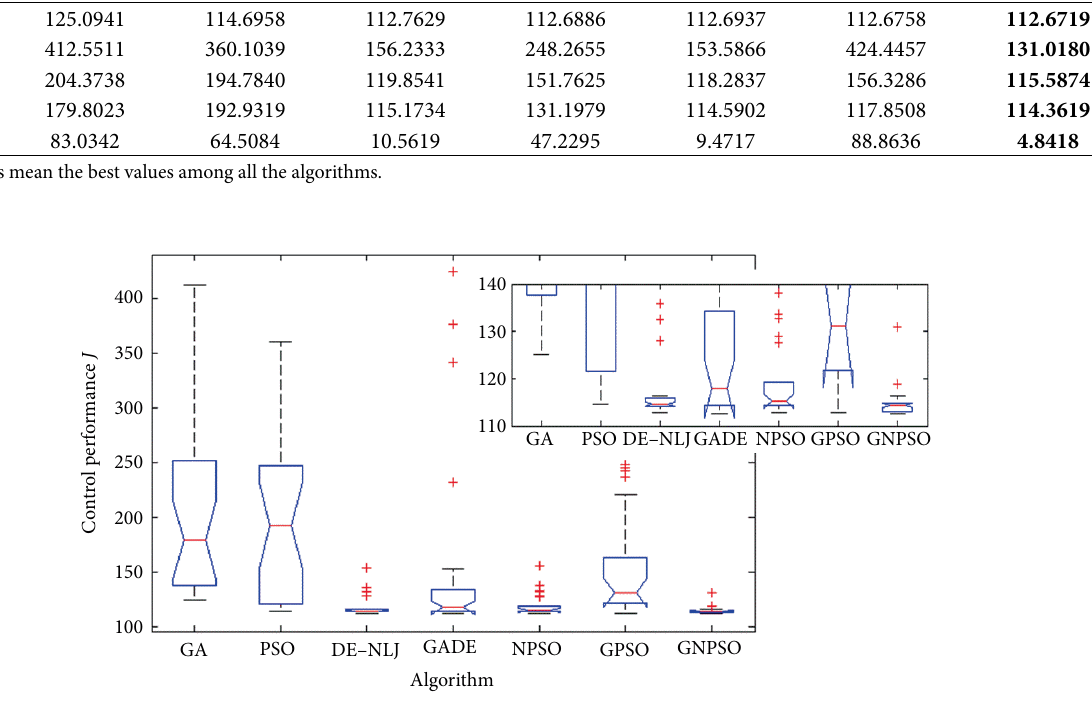
Figure 9: ANOVA tests of the control performance obtained by different algorithms for MIMO nonlinear wing vibration